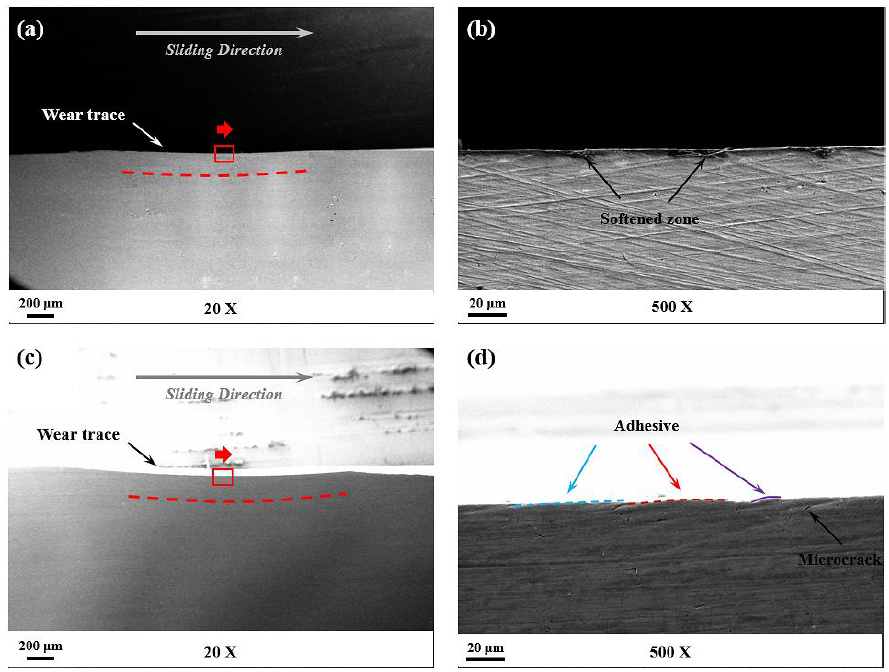
Figure 10. The worn sub-surface morphologies of the HCCI alloy under di ff erent loads: ( a , b ) 300 N; ( c , d ) 900 N.